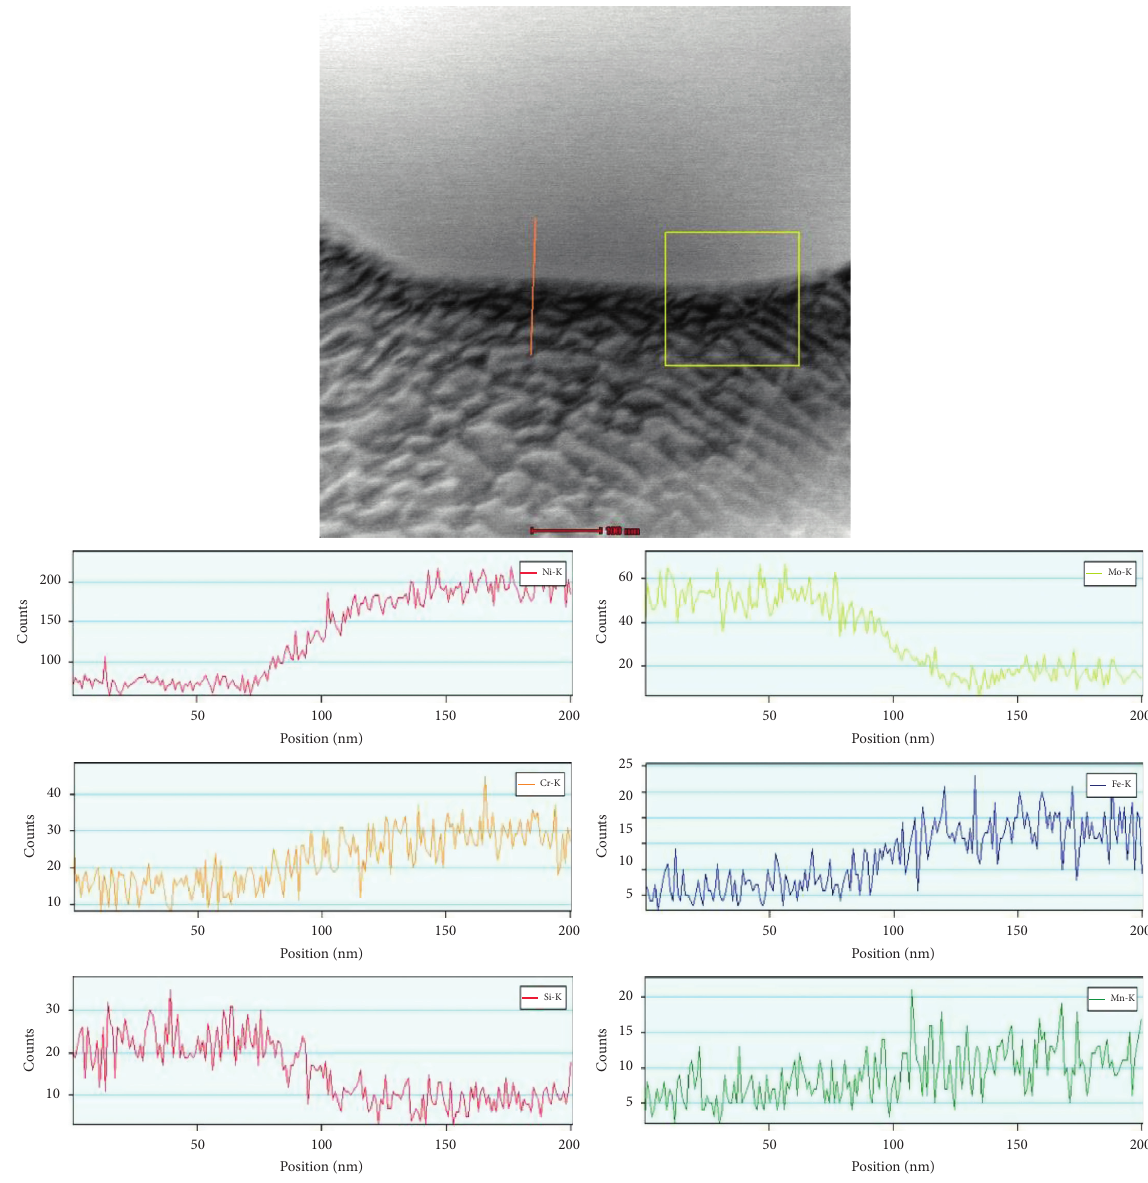
Figure 8: Distribution of elements in the second phase and Hastelloy N matrix after irradiation